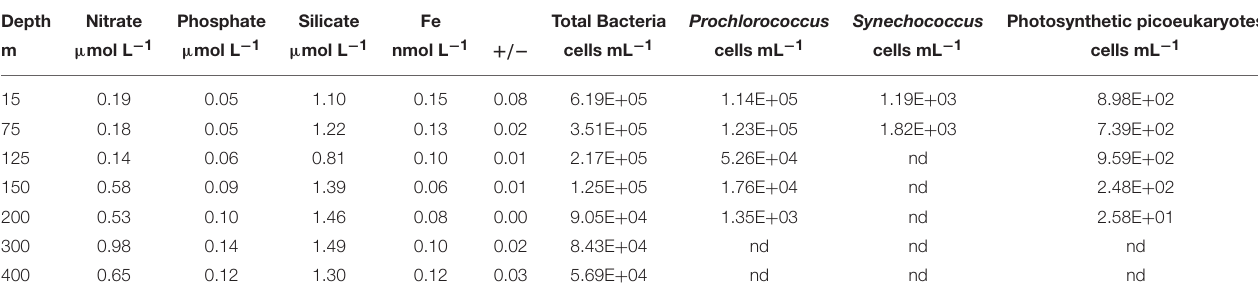
TABLE 1 | Macro (nitrate, phosphate, silicate) and micro (dissolved iron) nutrient concentrations and cell counts (heterotrophic bacteria, Prochlorococcus , Synechococcus , and photosynthetic picoeukaryotes) determined from 15 to 400m at Station ALOHA. Depth